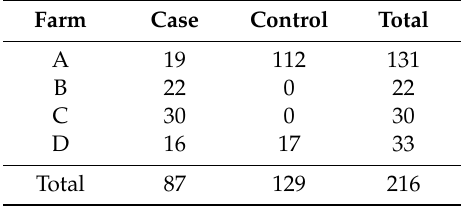
Table 1. Distribution of digital dermatitis cases and non-lame controls across the four dairies. Farm